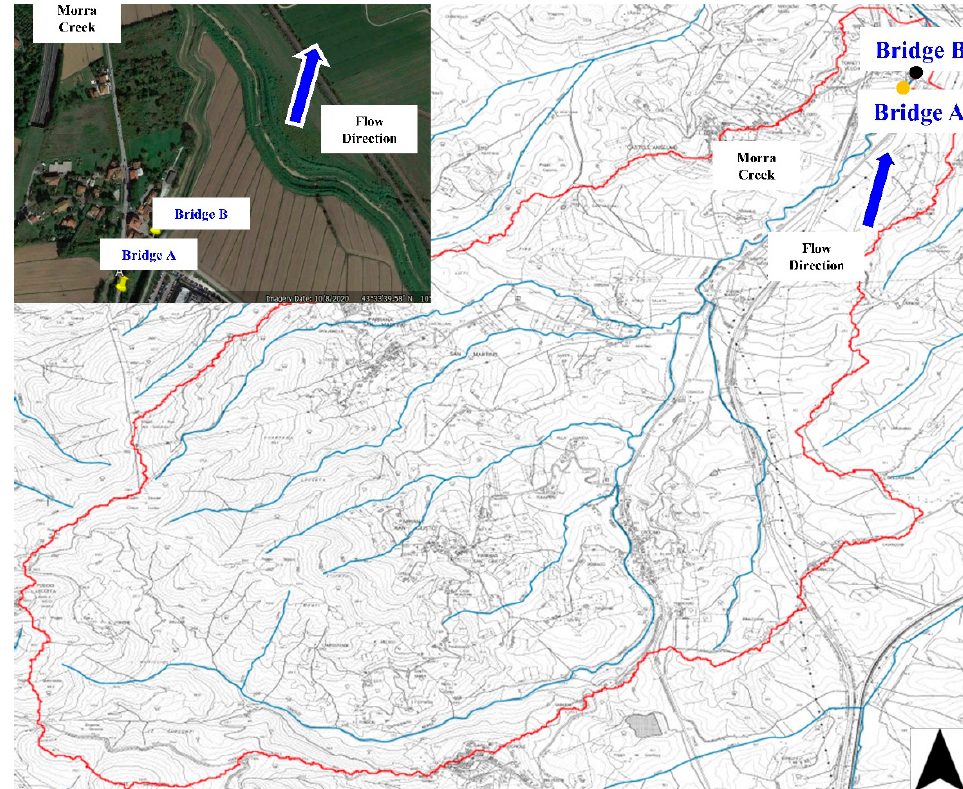
Figure 2. Morra Basin overview and locations of “Bridge A” and “Bridge B” cross-sections (yellow and black filled circles) along Morra Creek (soft blue line). The blue arrow indicates the flow direc-